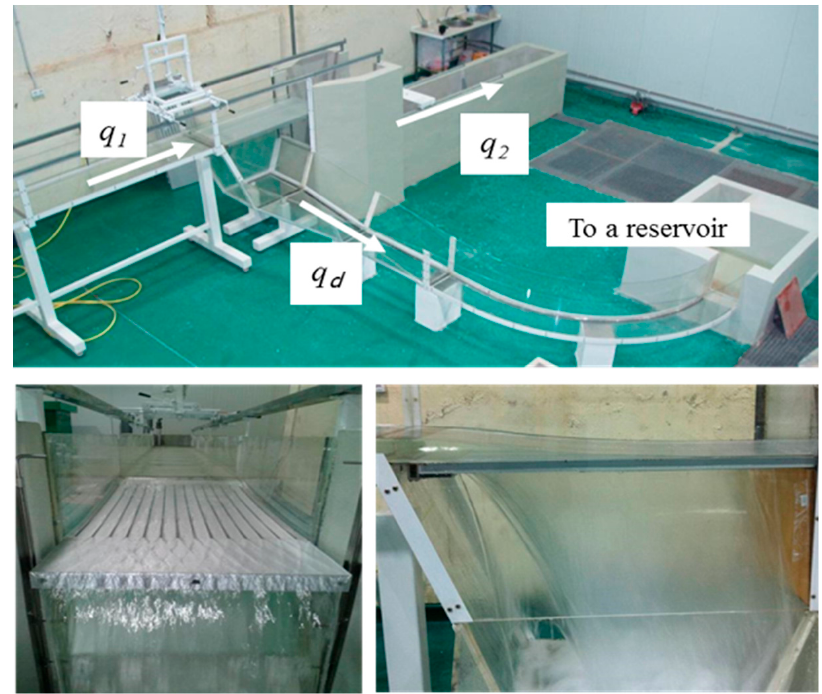
Figure 3. Bottom intake system at the Hydraulic Laboratory of the Universidad Politécnica de Cartagena.